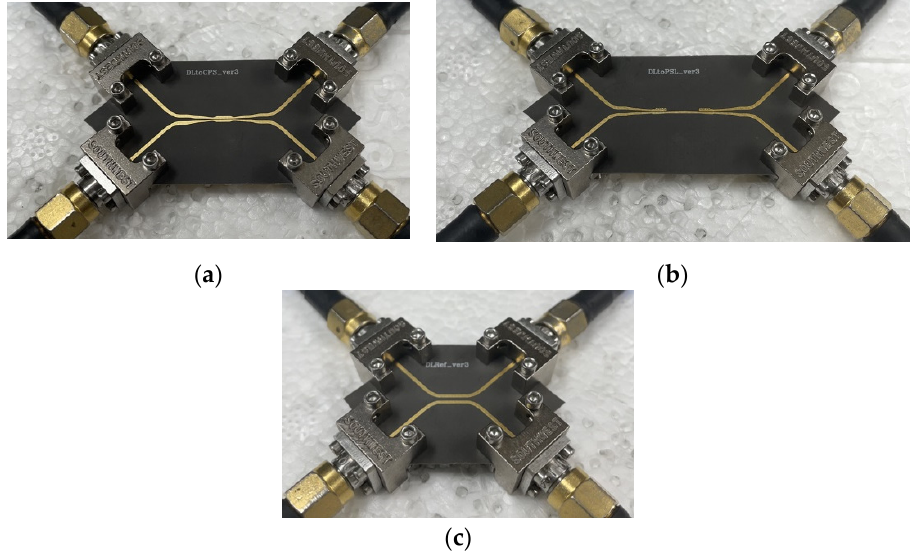
Figure 19. Pictures of the fabricated transitions and the Thru structure with the end-launch connect- ors: ( a ) DL-to-CPS transition, ( b ) DL-to-PSL transition, ( c ) 2X-Thru structure.